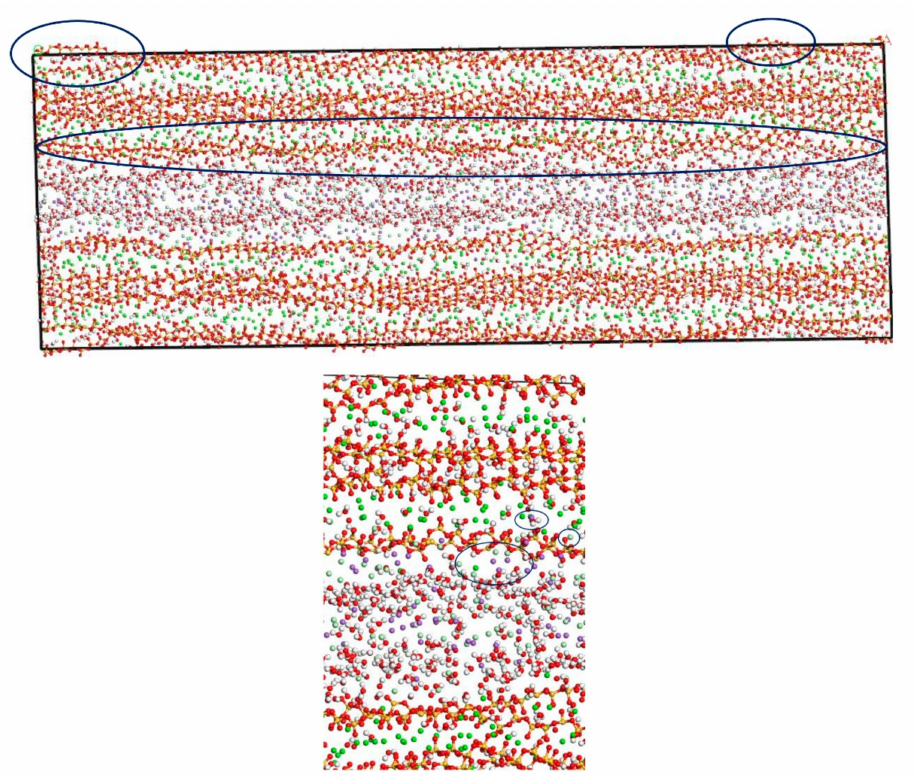
Figure 7. Transport properties of NaCl in C-S-H nanopores with pore size 1.5 nm under fatigue loading (green balls are Ca 2 + , yellow balls are Si atoms, purple balls are Na + , light green balls are Cl − , red balls are O atoms, white balls are H atoms).